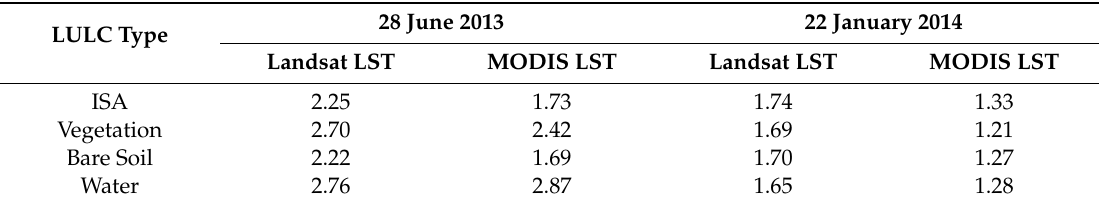
Table 3. The root-mean-square error RMSE ( ℃ ) of different land use/land cover (LULC) between Landsat/MODIS LST and “Landsat-like” LST.